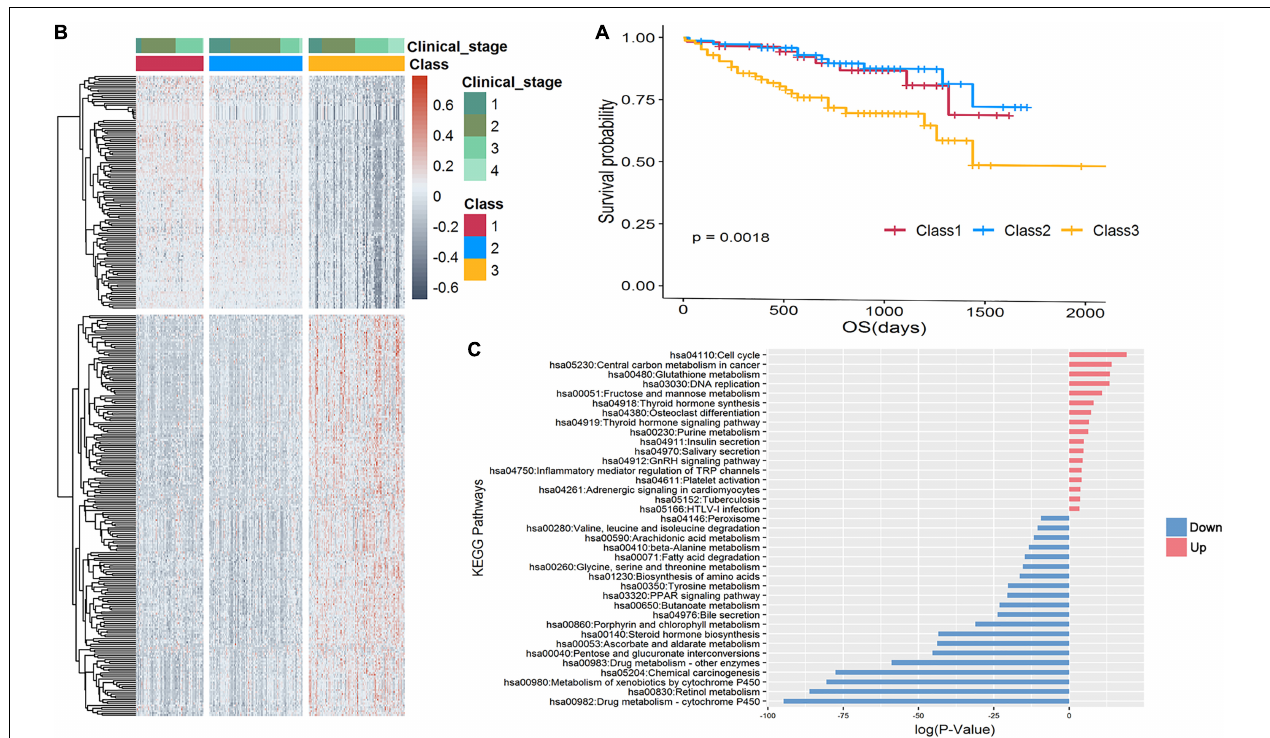
FIGURE 4 | Stratification of 232 LIRI-JP samples. (A) Kaplan-Meier curve shows the survival outcomes of Class 1 (red), Class 2 (blue), and Class 3 (yellow); the P -value is 0.0018, which is significant. (B) Heatmap of 332 differentially expressed genes revealed a distinguishable pattern between Class 3 and Class 1 and 2. Red color represents upregulated while dark gray represents downregulated. (C) Enrichment analysis of KEGG pathways of 210 upregulated and 122 downregulated genes,